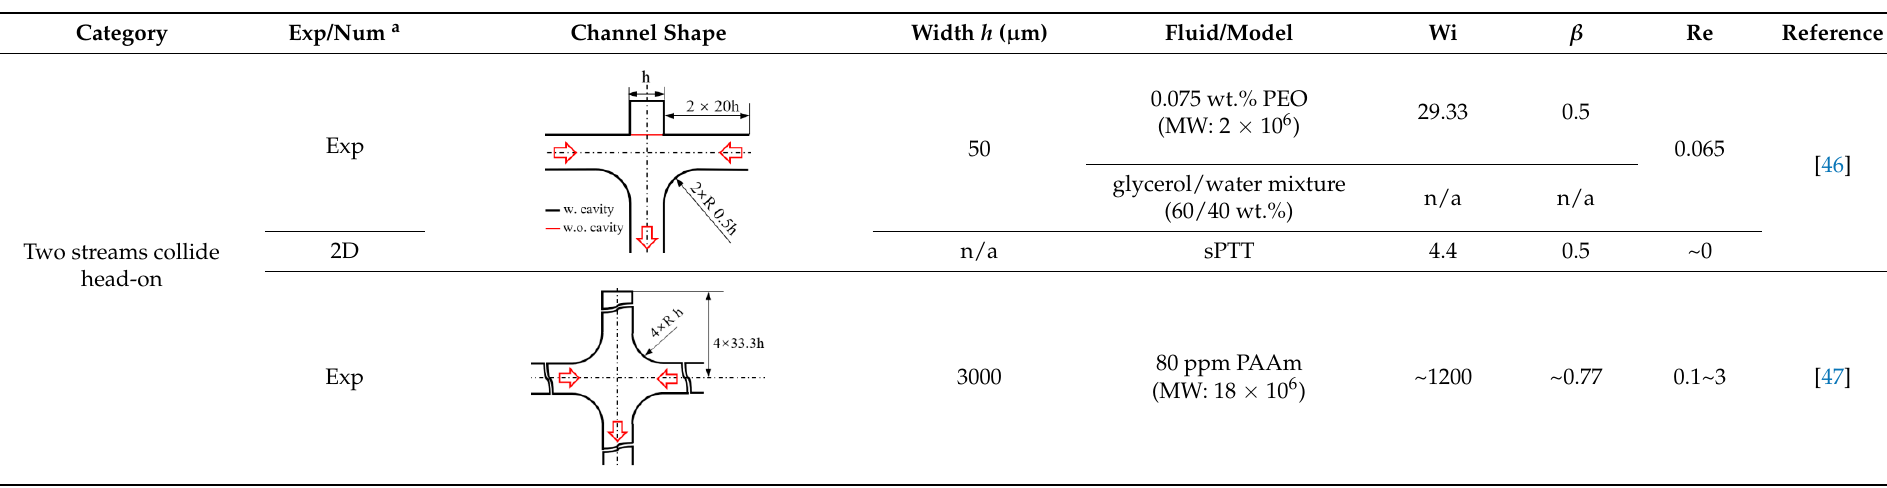
Table 2. A summary of different flow patterns of viscoelastic fluids in various typical T-shaped structures in recent years.